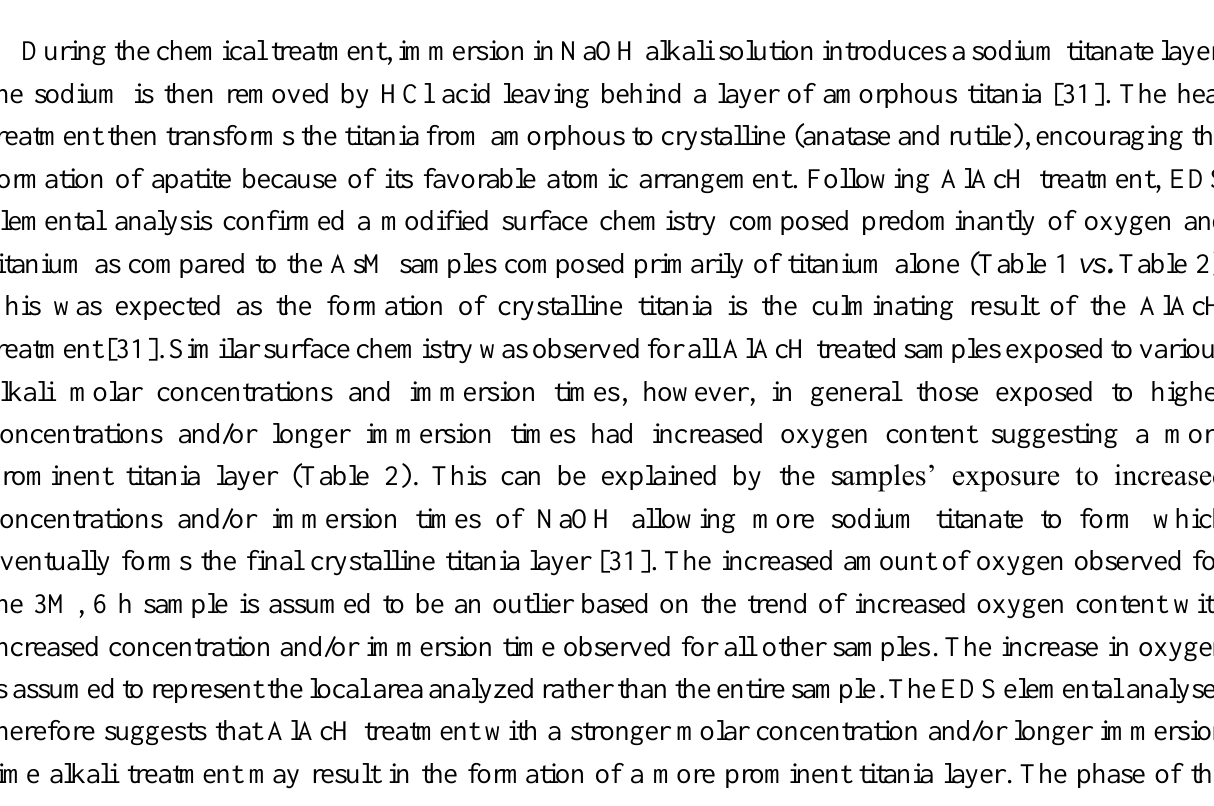
Figure 2. SEM micrographs of samples after AlAcH treatment for various alkali parameters ( a ) 3M, 6 h ( b ) 3M, 24 h ( c ) 5M, 6 h ( d ) 5M, 24 h ( e ) 10M, 6 h and ( f ) 10M, 24